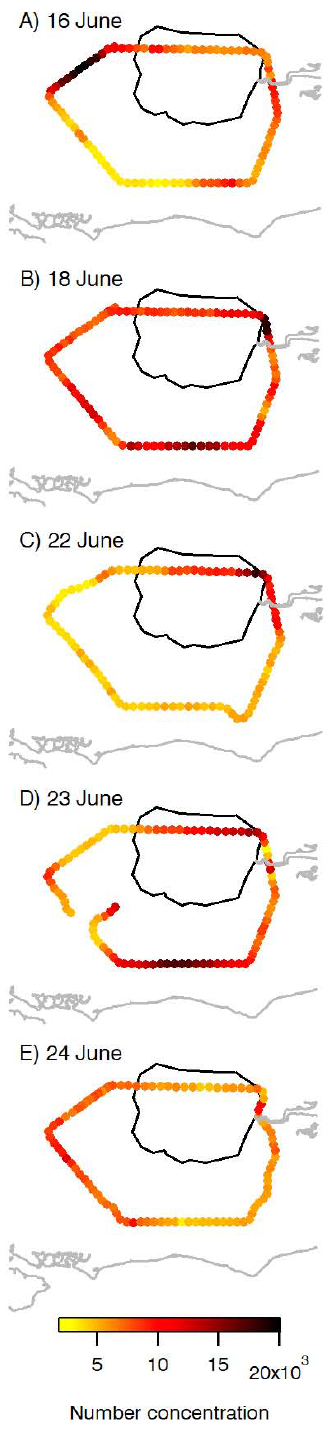
Fig. 7. Number concentrations for particles with D p > 3nm mea- sured by the ultrafine water-based condensation particle counter for single circuits around London during each flight. Note scale on panel (d) has been adjusted by a factor of 2 (maximum N =40000cm − 3 ) to better illustrate the variability along the flight